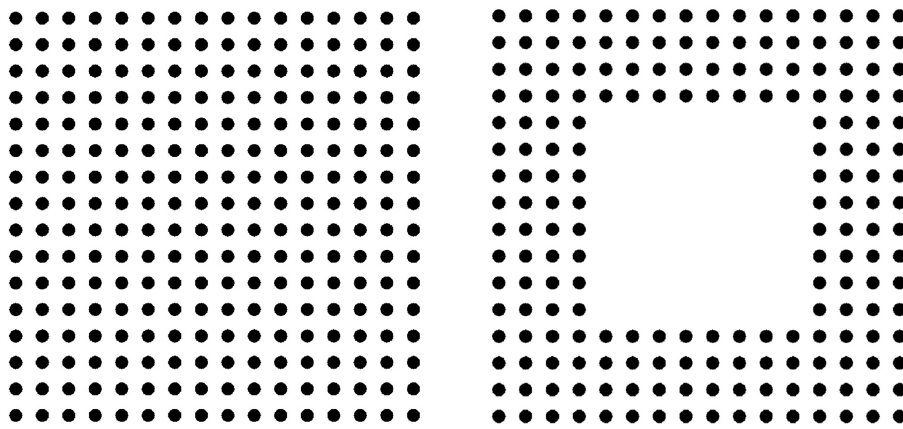
Figure 1: Solder array layouts: × 16 16 full ( left ) and peripheral ( right )